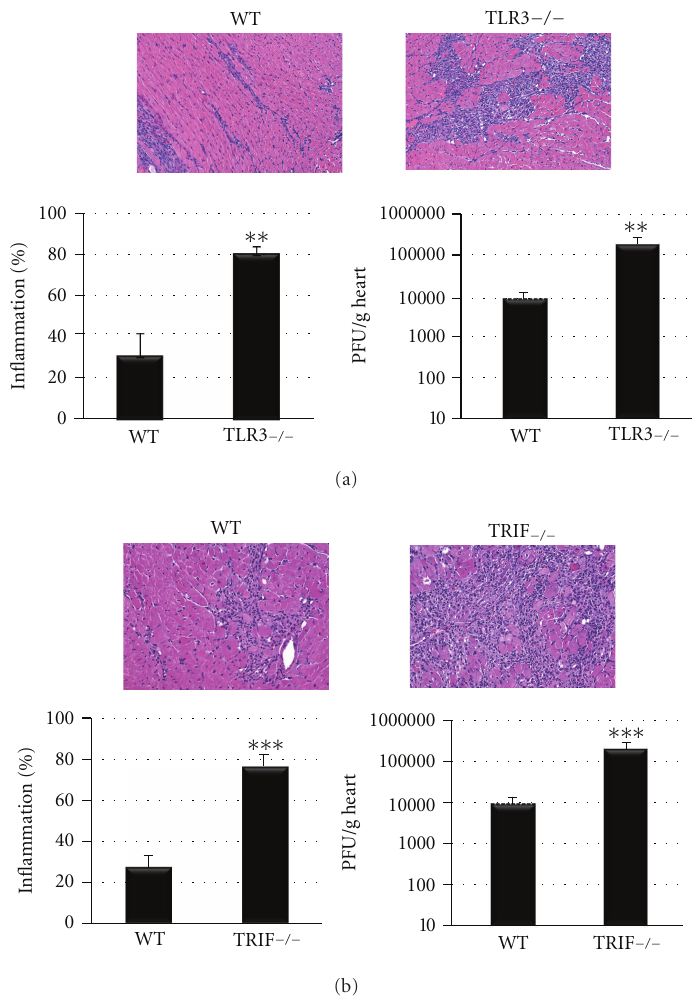
Figure 1: Inflammation and viral replication increase in a similar manner in TLR3-deficient (TLR3 − / − ) or TRIF − / − mice during acute CVB3 myocarditis. (a) TLR3 − / − mice developed increased inflammation and viral replication at day 10 pi compared to WT B6.129 controls. (a) Representative histology sections of inflammation in WT and TLR3 − / − hearts stained with H&E (top), magnification × 64. (b) TRIF − / − mice develop increased inflammation and viral replication at day 10pi compared to WT BL/6 controls. (b) Representative histology sections of inflammation in WT and TRIF − / − hearts stained with H&E (top), magnification × 64. Data show the mean ± SEM of at least three separate experiments using 7 to 12 mice/group. ∗∗ : P < 0 . 01, ∗∗∗ : P < 0 .